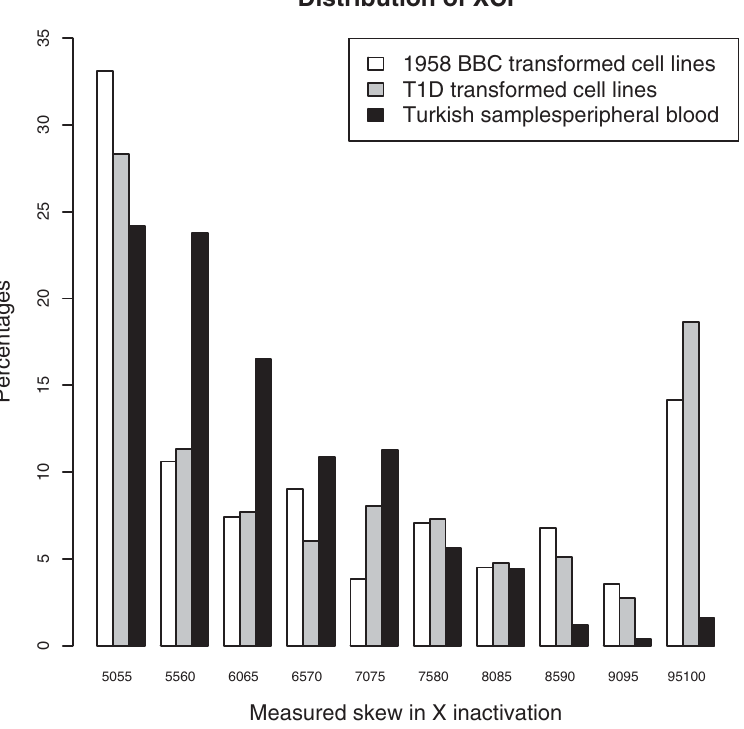
Figure 1. Distribution of XCI in the British 1958 Birth Cohort samples, JDRF/WT T1D cases collection (both with DNA extracted from transformed cells lines) and the control Turkish population (DNA extracted from peripheral blood).